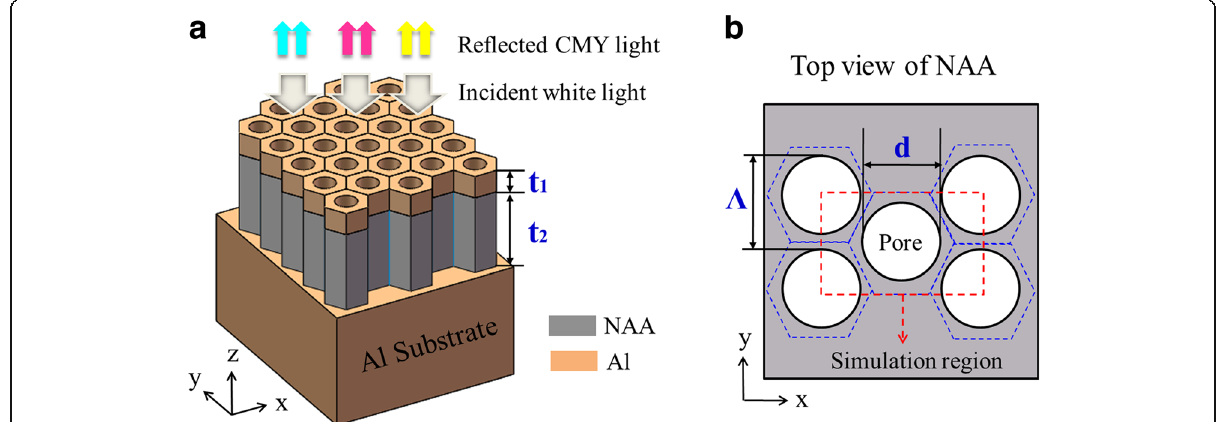
Fig. 1 a Schematic geometry of the proposed structure based on the Al-coated NAA film atop an Al substrate for large-area color filtering. b Top view of the NAA film with a hexagonal lattice of nanopores